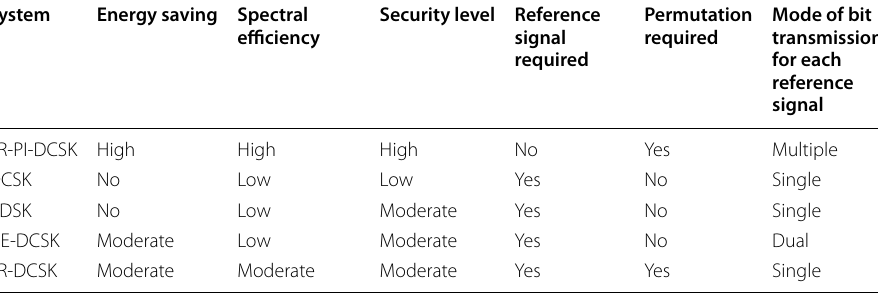
Table 1 Chaos‑based communication systems comparison